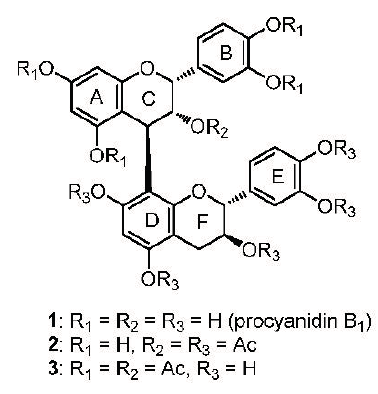
Figure 1. Structure of procyanidin B1 ( 1 ) and semi-acetylated analogues: lower-unit acetylated B1 ( 2 ) and upper-unit acetylated B1 ( 3 ).